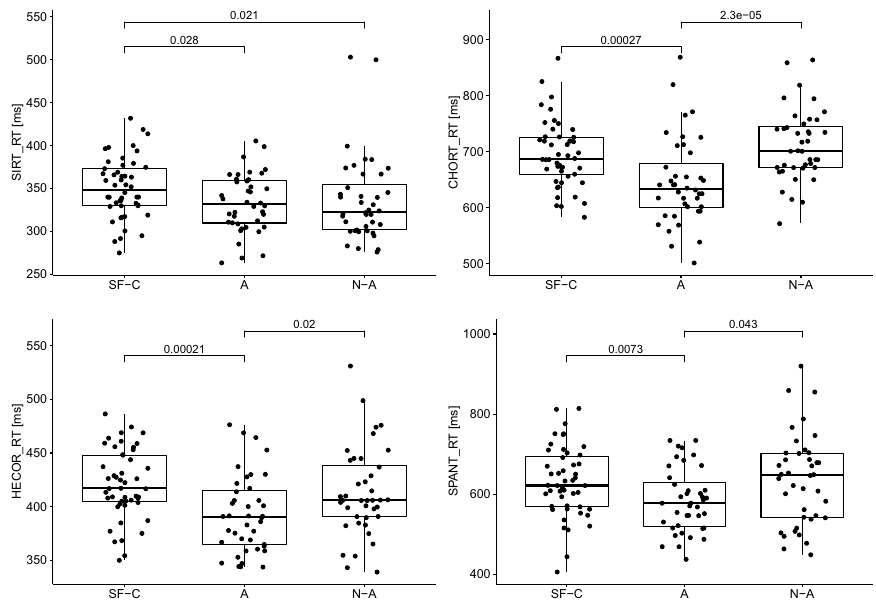
Figure 2. Reaction time for each groups.